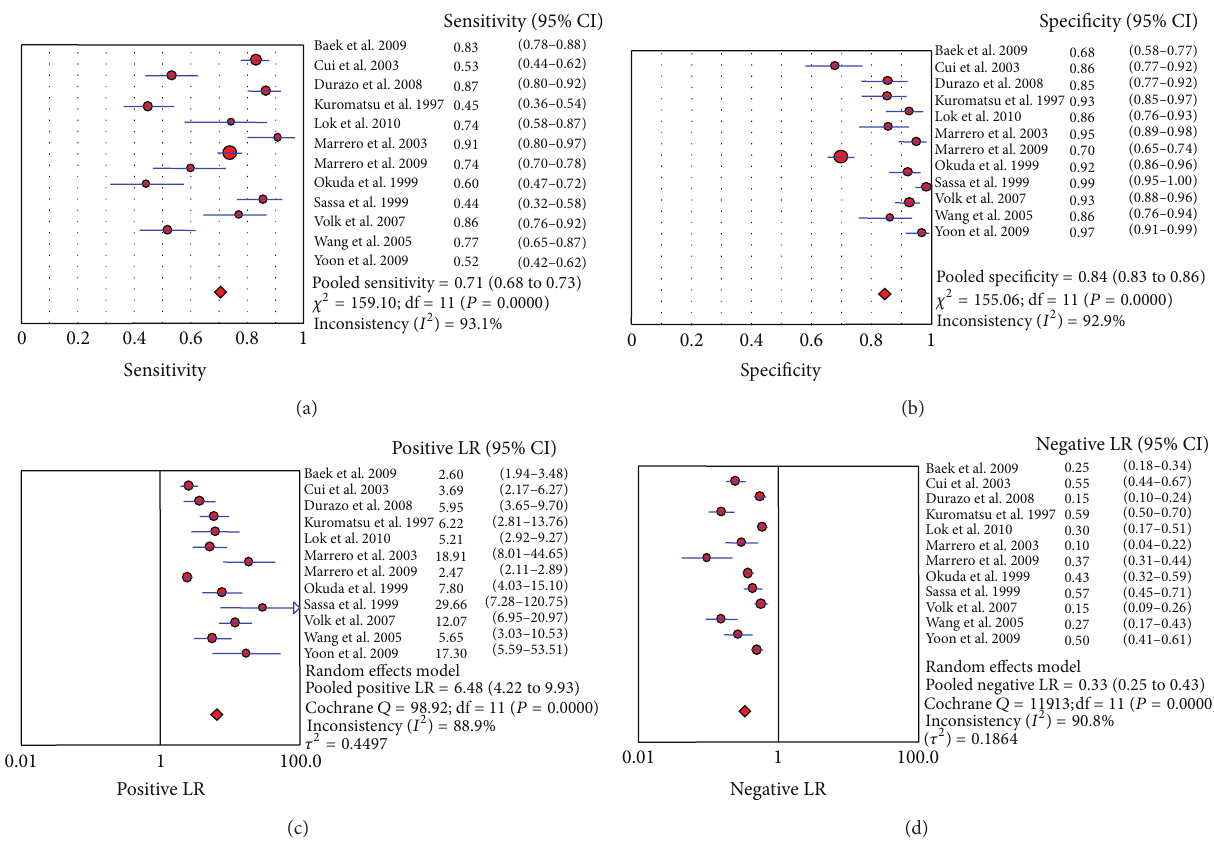
Figure 5: Forest map of the meta-analysis of each index: (a) sensitivity, (b) specificity, (c) PLR, and (d) NLR. of the included studies was quite different. The